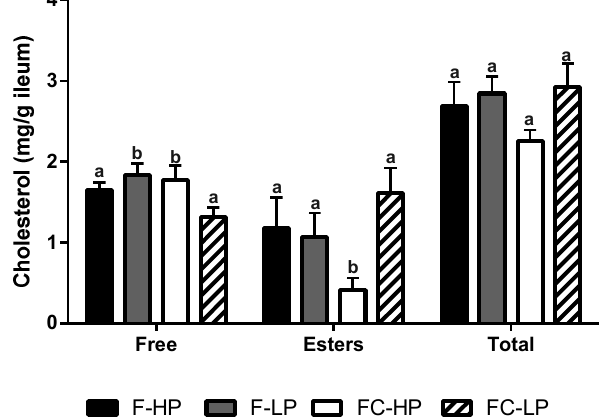
Figure 2. Free cholesterol, cholesterol esters, and total cholesterol (free + esters) concentrations in the ileal tissue of piglets fed different infant formulas containing high (F-HP) or low (F-LP) PS concentrations, supplemented with cholesterol (FC-HP, FC-LP) to achieve concentrations similar to human milk. Data are means ± SEM, n = 8/diet group. Statistical differences were determined by Two-way ANOVA; for free cholesterol, p = 0.371 for PS, p = 0.183 for cholesterol, and p < 0.05 for interaction; for cholesterol esters, p = 0.074 for PS, p = 0.701 for cholesterol, and p < 0.05 for interaction; for total cholesterol, p = 0.470 for PS, p = 0.098 for cholesterol, and p = 0.289 for interaction, Student Newman-Keuls post hoc analysis. Bars without a common letter significantly differ from each other, p < 0.05.